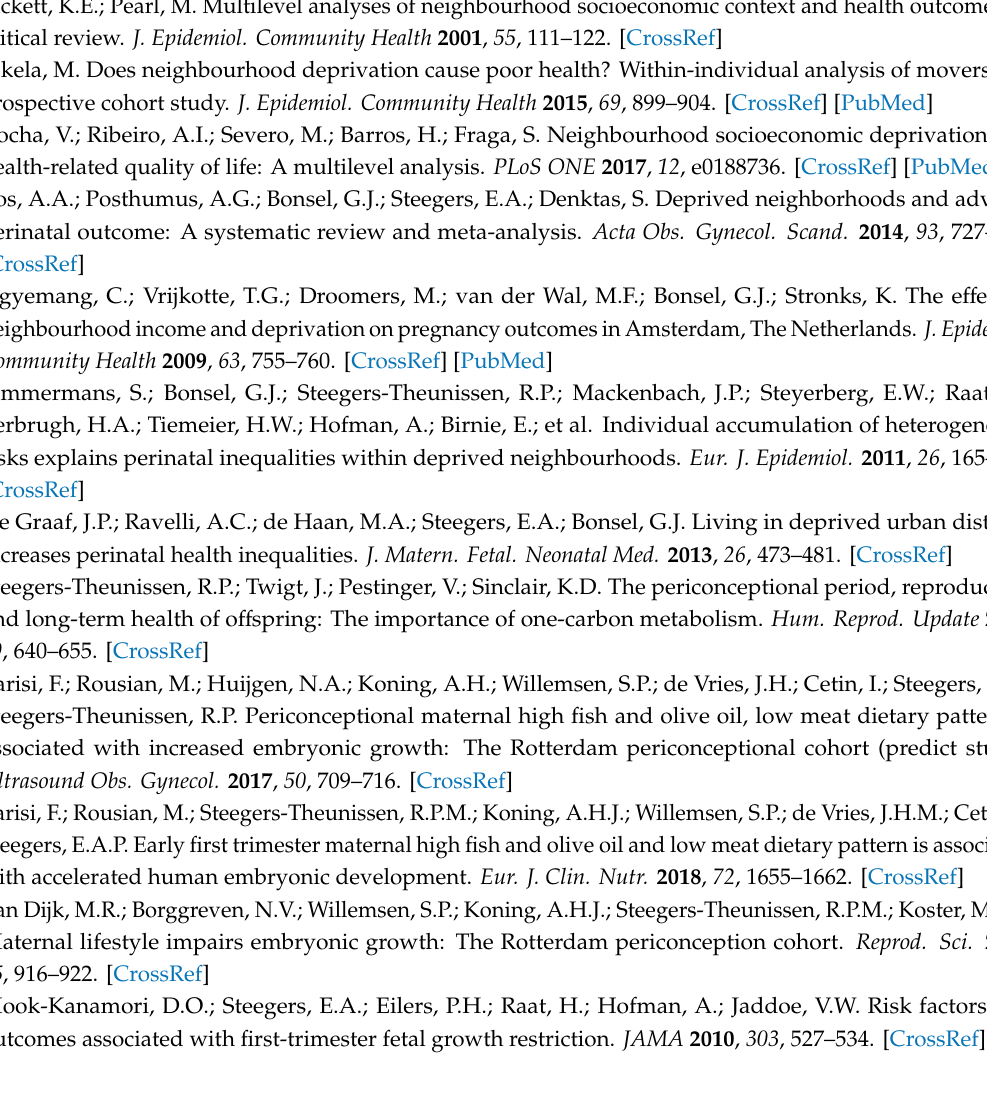
Figure S1: Full adjusted models for (A) crown-rump length and (B) embryonic volume in the lowest, middle and highest groups of the NSS, Table S1: Maternal baseline characteristics of women who were included and excluded from analysis, Table S2: Maternal baseline characteristics and nutrition and lifestyle behaviours of the study population, stratified for spontaneous pregnancies and IVF / ICSI pregnancies, Table S3: Associations between the neighbourhood status score (NSS) and embryonic growth trajectories, expressed as longitudinal crown-rump length (CRL) and embryonic volume (EV) measurements, stratified for spontaneous pregnancies and IVF / ICSI